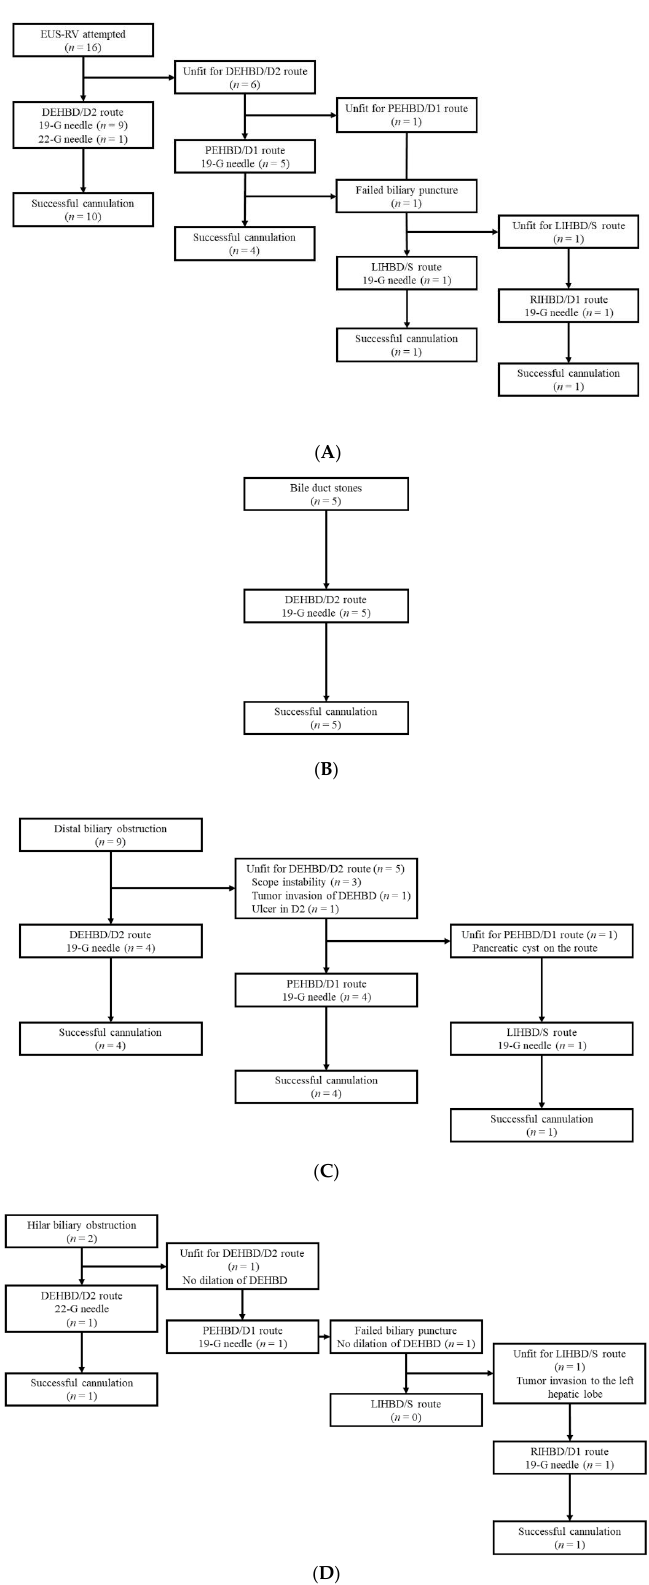
Figure 7. Approach routes and needle sizes according to the biliary disorders. All patients ( A ), bile duct stones ( B ), distal biliary obstruction ( C ), and hilar biliary obstruction ( D ). DEHBD/D2: distal extrahepatic bile duct/duodenal second part; PEHBD/D1: proximal extrahepatic bile duct/duodenal bulb; LIHBD/S: left intrahepatic bile duct/stomach; RIHBD/D1: right intrahepatic bile duct/duodenal bulb; EUS-RV: endoscopic ultrasound-guided rendezvous.